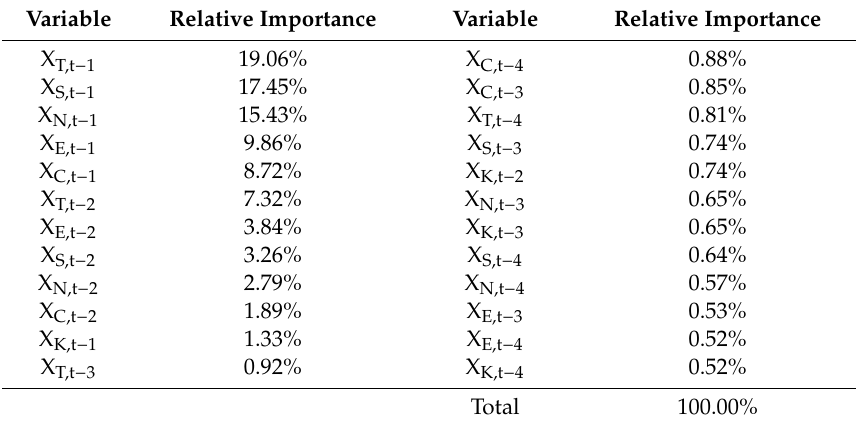
Table 4. The relative importance value of each predictor variable based on the proposed